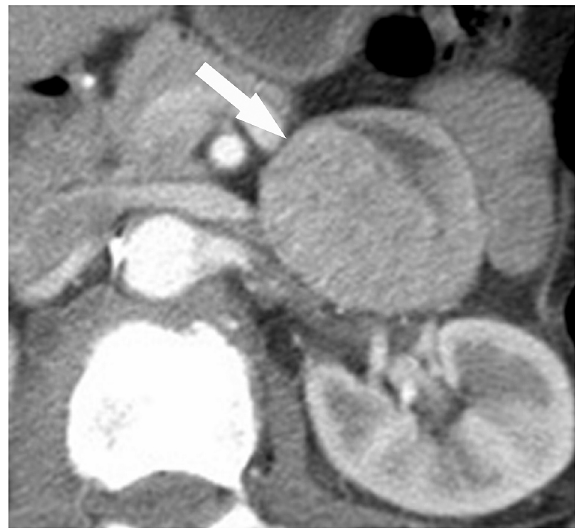
Figure 2 – Axial contrast-enhanced portal venous phase CT scan in a 64 year old woman with abdominal pain (Case 2 in Table-1). A heterogeneously enhancing mass (arrow) is seen anterior to the left renal vessels. The left adrenal gland (not shown) was identi- fied just superior to this mass. Open exploratory laparotomy and adrenalectomy was performed, based on a preoperative working diagnosis of retroperitoneal sarcoma. Surgery demonstrated a mass arising exophytically from the inferior aspect of the left adrenal gland, and was complicated by intraoperative hemody- namic instability. The mass was removed expeditiously and final pathology revealed a diagnosis of